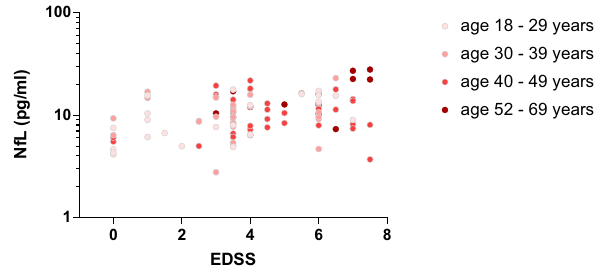
Fig. 6 Worsening of EDSS-graded myelopathy in AMN is re fl ected by increased NfL. The potential dependence of log of NfL on EDSS-graded clinical severity in individual asymptomatic X-ALD and AMN patients ( n = 68, total sample number = 101 samples) was analyzed using a linear mixed model with fi xed effects EDSS as well as age and sample type as adjustment variables and a random ID factor (two-sided test). The adjusted slope of the linear regression is back-transformed to the original scale, thus resulting in a percentage change, estimated as 6% higher NfL for each additional EDSS score point (95% CI: 0.7 – 11.4%, p = 0.026). Source data are provided as a Source Data fi